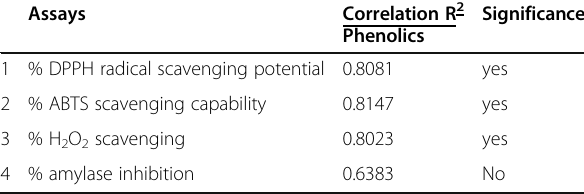
Table 4 The correlation between total phenolic content quantified in methanolic extract of rhizome of Sorghum halepense (L.) Pers and its different soluble fractions and their antioxidant and antidiabetic potency. P -value (two-tailed) and ns: none